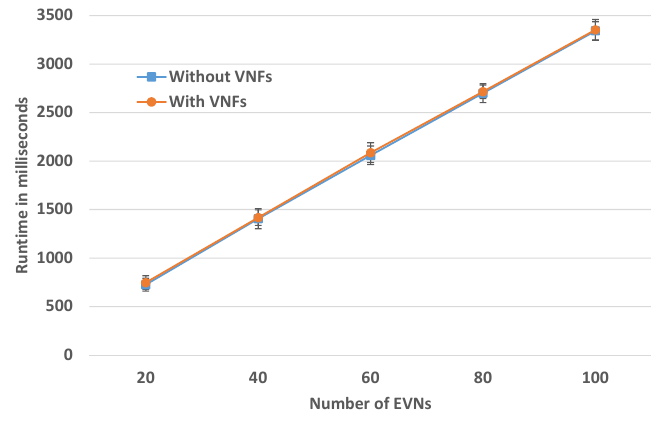
Figure 10. Runtime for increased number of EVNs.